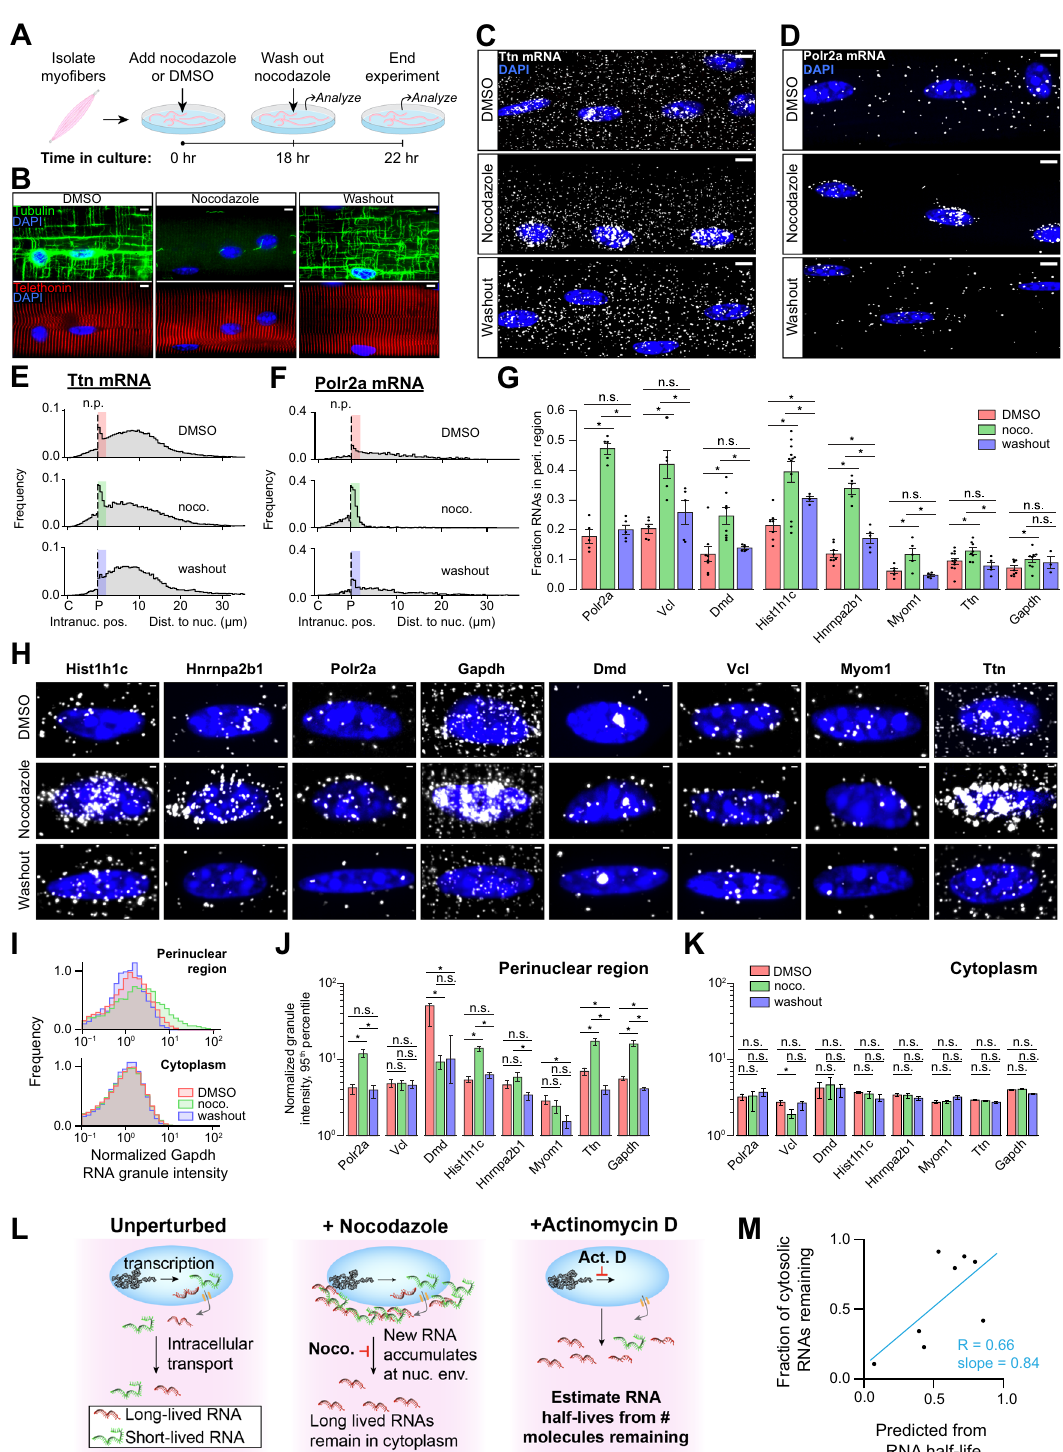
treatment ( p < 0.05 by 95% CI overlap, Fig. 4I – K). After removing nocodazole for 4 h, blob intensities decreased to levels at or below those observed in untreated myo fi bers. Dmd was a notable out-